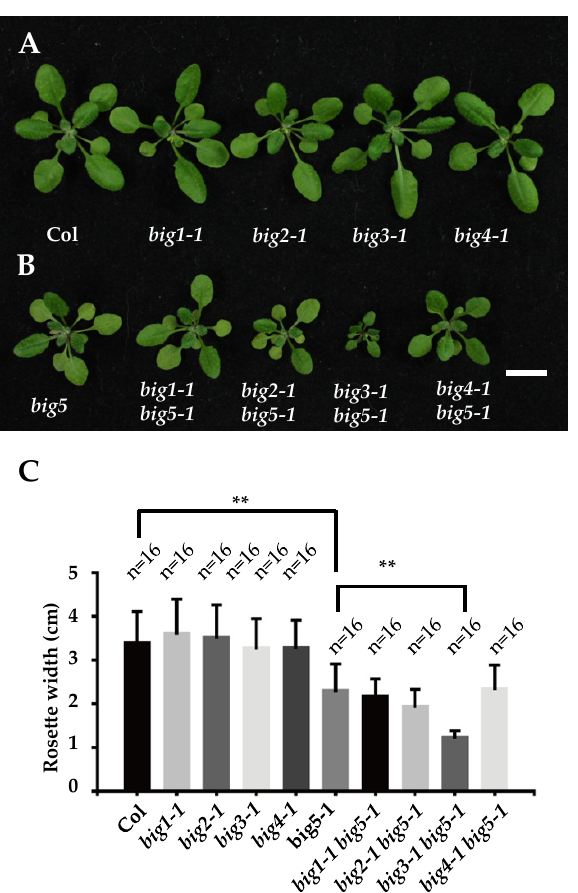
Figure 1 Growth phenotypes of BIG ‐ subfamily mutants. Figure 1. Growth phenotypes of BIG-subfamily mutants. ( A ) Overall growth 4-week-old seedling of BIG-subfamily single mutants, big1-1 , big1-2 , big3-1 , big4-1 exhibit similar size with Col. ( B ) big5-1 (A) Overall growth 4 ‐ week ‐ old seedling of BIG ‐ subfamily single mutants, big1 ‐ 1 , big1 ‐ 2 , big3 ‐ 1 , big4 ‐ 1 shows a reduced rosette size. big1-1 big5-1 , big2-1 big5-1 , and big4-1 big5-1 double mutants have a exhibit similar size with Col. (B) big5 ‐ 1 shows a reduced rosette size. big1 ‐ 1 big5 ‐ 1 , big2 ‐ 1 big5 ‐ 1 , and similar seedling size with big5-1 . Only big3-1 big5-1 double mutant shows an aggregated growth defects. ( C ) Quantitative analysis of rosette width. Bars = 1 cm. Error bars represent standard deviations, big4 ‐ 1 big5 ‐ 1 double mutants have a similar seedling size with big5 ‐ 1 . Only big3 ‐ 1 big5 ‐ 1 double mutant significant di ff erence after Student’s t -test, ** p < shows an aggregated growth defects. (C) Quantitative analysis of rosette width. Bars=1 cm. Error bars represent standard deviations, significant difference after Student’s t ‐ test, ** P <0.01.